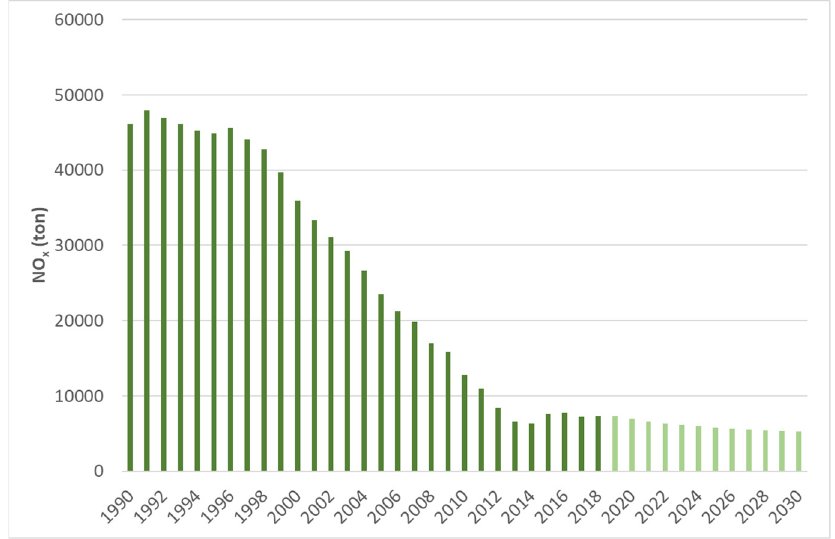
Figure 14. Total NO x emissions from passenger cars in Greece for the period 1990–2030.